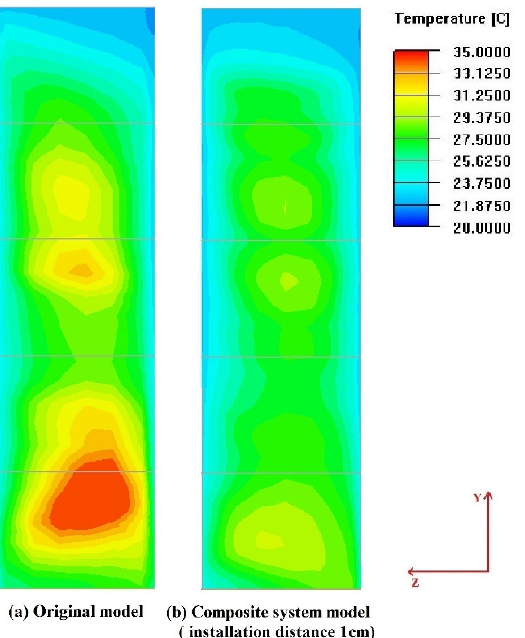
Figure 8. The profile of heat distribution of the back door in rack B4 with the original and new cooling systems.